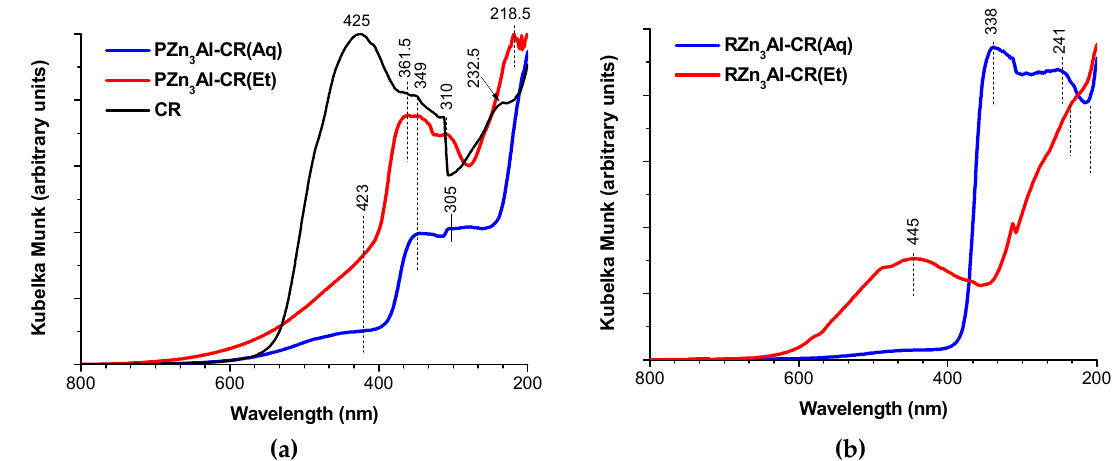
Figure 7. Diffuse reflectance (DR)-UV–Vis spectra: ( a ) neat curcumin (CR) and precipitated samples, PZn3Al-CR(Aq), PZn3Al-CR(Et); ( b ) reconstructed samples RZn3Al-CR(Aq), RZn3Al-CR(Et).